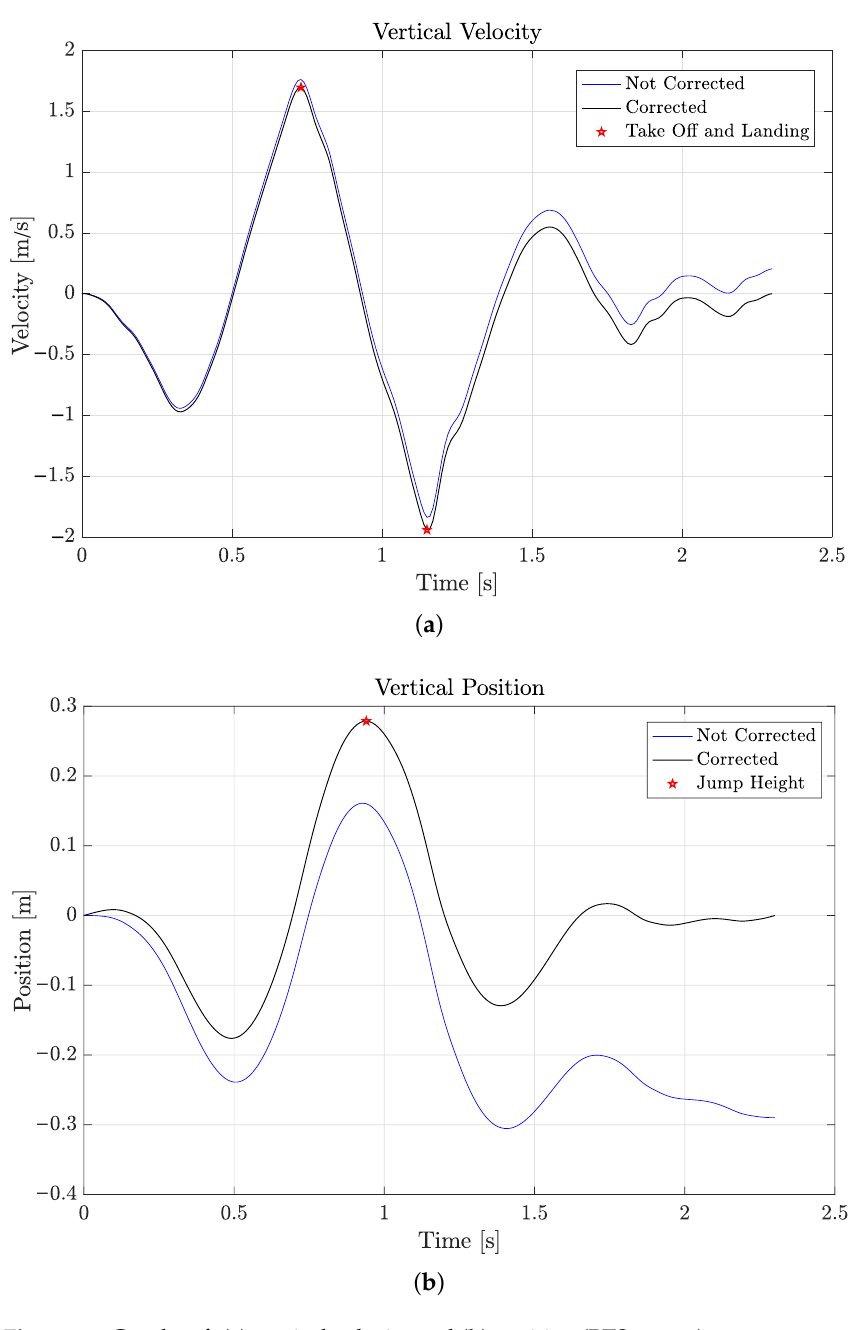
Figure 11. Graphs of: ( a ) vertical velocity and ( b ) position (BTS sensor). For this test as well, data recordings were carried out on two different healthy patients: a 34-year-old male and a 24-year-old female. Sensors were positioned on the last lumbar vertebra, which corresponds to the L5 vertebra, and were firmly attached to the body with the supplied straps. Every measurement was taken three times with each of the